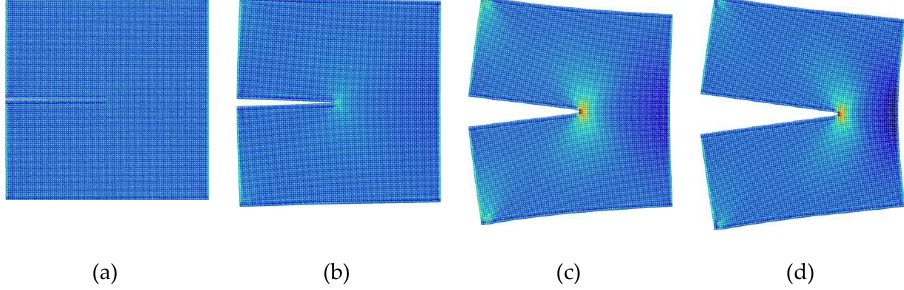
Figure 6. Snapshots of the atomistic configuration corresponding to different stages of the Ni nanoplate with a crack length of 25 c . Atoms are colored according to the σ 22 component of the atomic stress, with blue indicatinglow stress and red representing high stress. ( a ) Initial relaxed state before applying tensile displacement. ( b ) The linear stage. ( c ) Immediately before the crack propagation. ( d ) The declining stage.